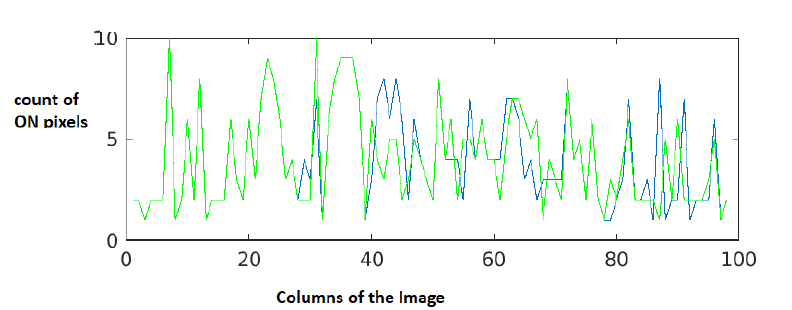
Figure 13. Overlapped results of histogram projections of line 1 and line